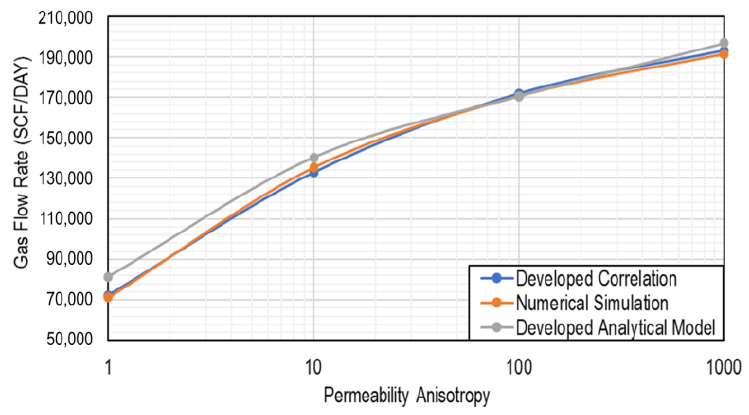
Figure 14. The effect of permeability anisotropy on cumulative production.